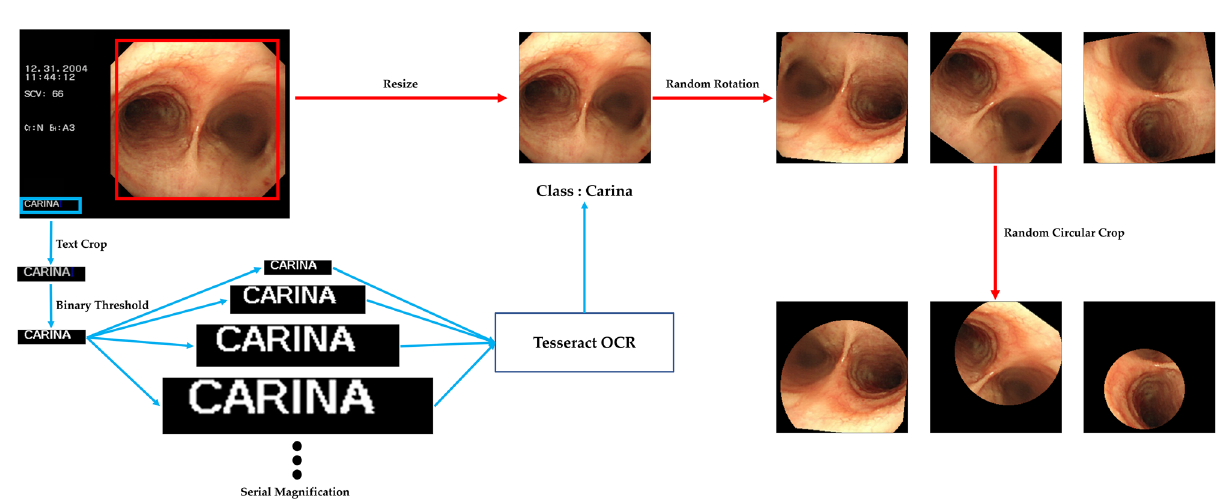
Figure 2. Data preparation and partitioning